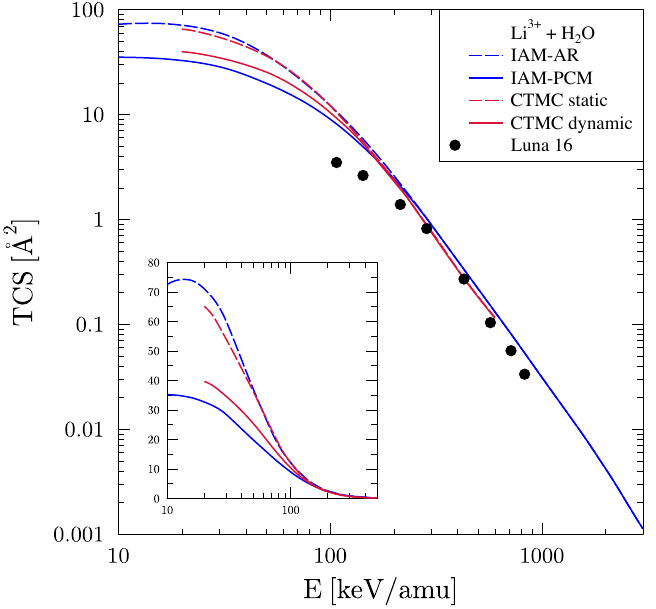
Figure 4. Net electron capture cross section for Li 3 + -water collisions. The curves follow the same pattern as described for Figure 2. The experimental data are from Reference